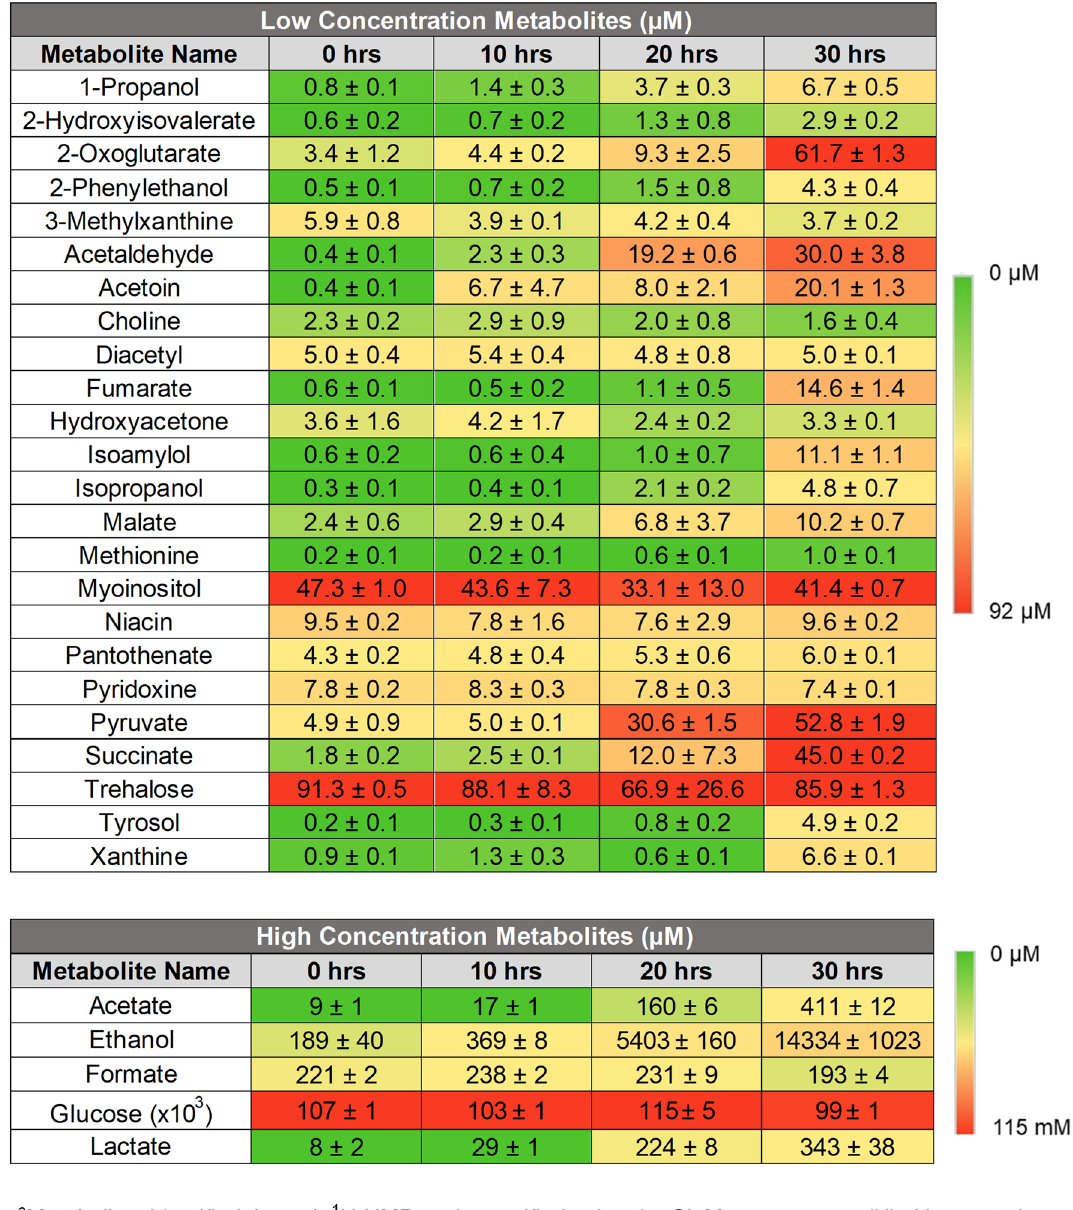
under high nitrogen conditions we were not able to observe many cells with three bud sites (Fig. 5e) due to the cell density becoming so high that single buds were no longer visible in the images. For this reason, we did not see a statistically significant increase in the budding pattern between 0–10 h and 20–30 h. Media from the time series experiment under high nitrogen conditions were also analysed by 1 H NMR to obtain compound concentrations over time. A list of the 29 compounds identified in our high nitrogen samples and their concentrations can be seen in Table 2. Metabolites potentially involved in the budding pattern switch were again chosen from the identified compound list as those that were not present as nutrients in the raw media and had concentrations that increased during growth. Here the metabolite concentrations which corresponded to the observed switch in budding pattern were 1-propanol (1.4–3.4 µM), 2-hydroxyisovalerate (0.4–0.5 µM), 2-oxoglutarate (1.5–2.0 µM), 2-phenylethanol (0.4–0.6 µM), acetaldehyde (2.0–18.0 µM), acetate (27–186 µM),